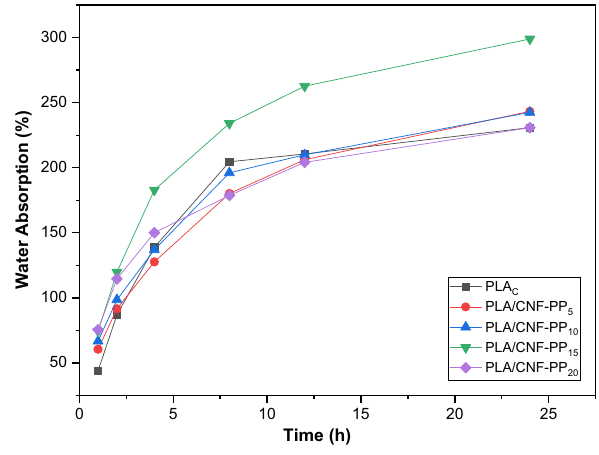
Figure 6: Water absorption measurements of PLA sca ff olds with di ff erent CNF contents as a function of soaking